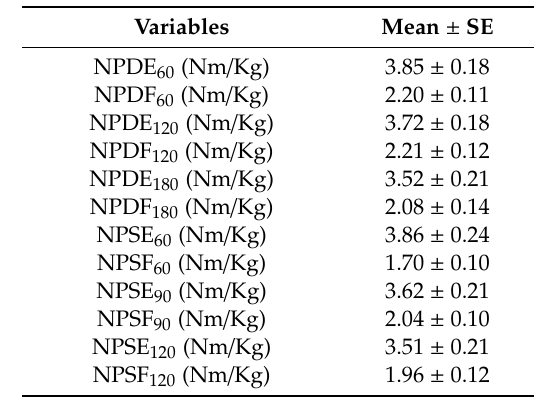
Table 1. Descriptive statistics for core strength measurements (n = 20).